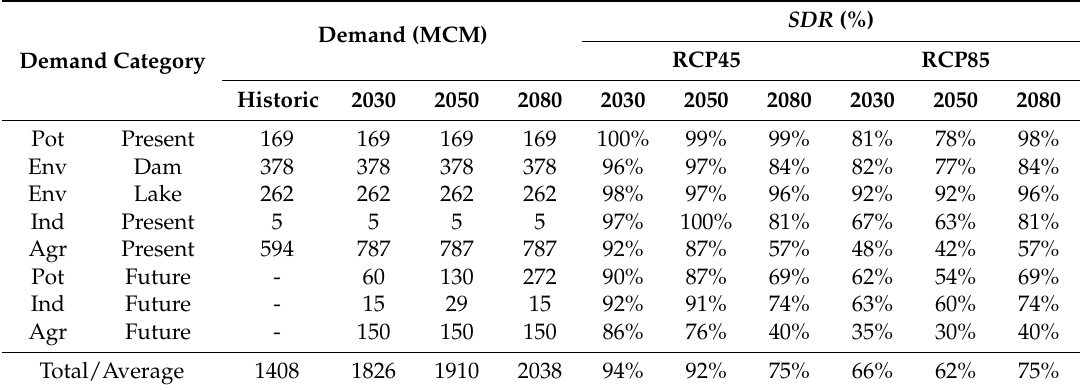
Table 6. Annual water demand for historical and future periods (2030, 2050, and 2080) under the eight categories in decreasing order, and the simulated supply/demand ratio ( SDR ) for these future periods under the RCP45 and RCP85 for the WD current water demand scenario.